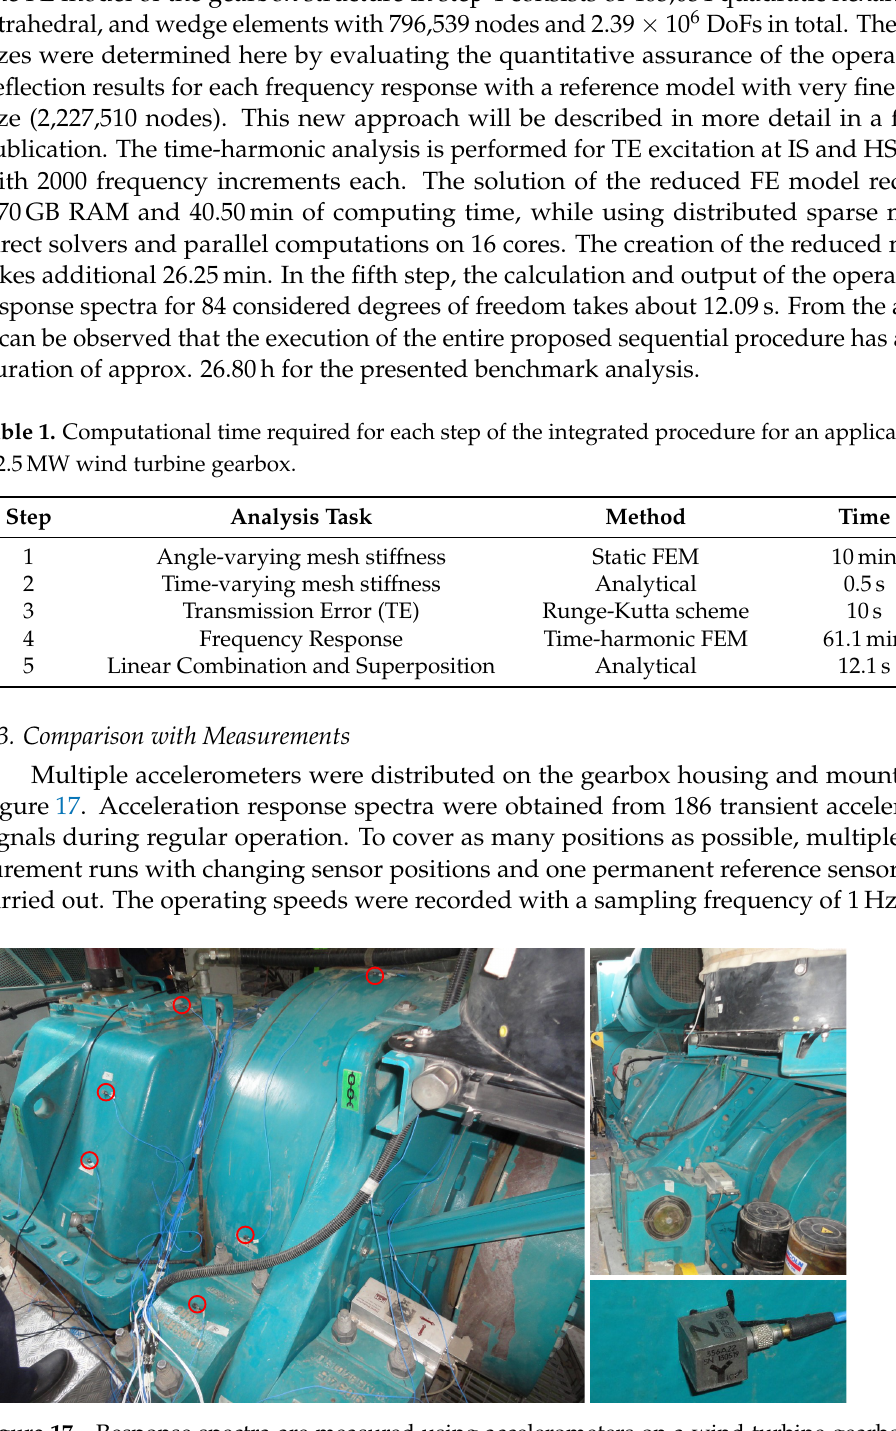
Figure 17. Response spectra are measured using accelerometers on a wind turbine gearbox dur- ing